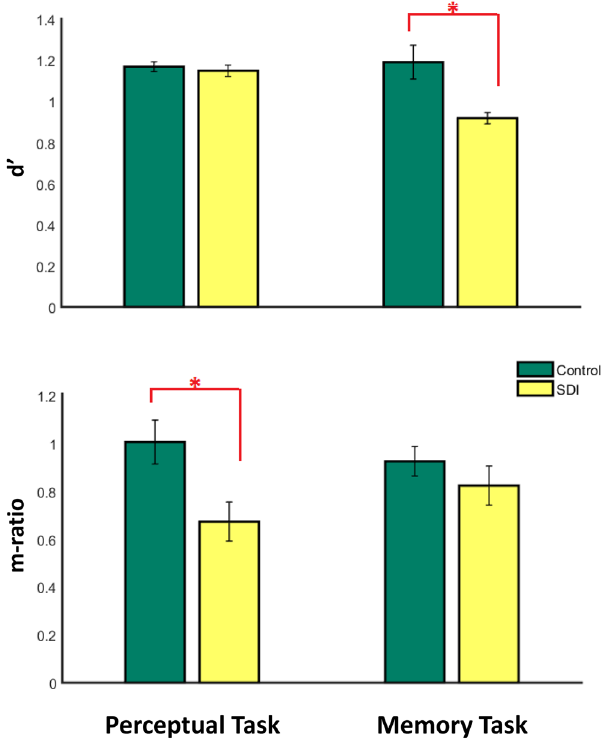
Figure 2. d ′ (top) and m-ratio (bottom) in perceptual (left) and memory (right) tasks. SDIs are significantly